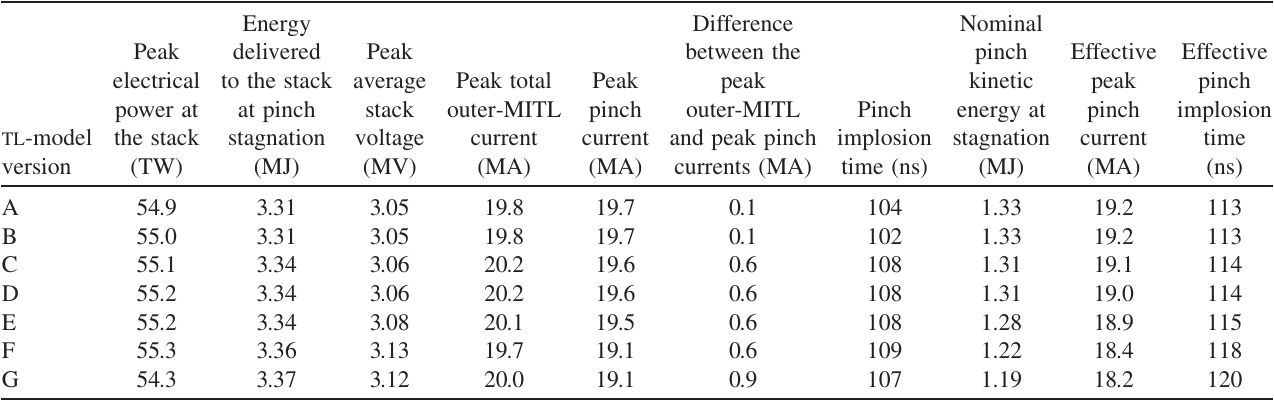
TABLE III. Calculated results given by the seven TL -model versions outlined by Table II. The results assume a z -pinch load with a 2- cm height, 2-cm initial radius, and 4.27-mg total mass, which was the Z accelerator’s baseline load. The effective peak pinch current and effective pinch implosion time are defined in Appendix